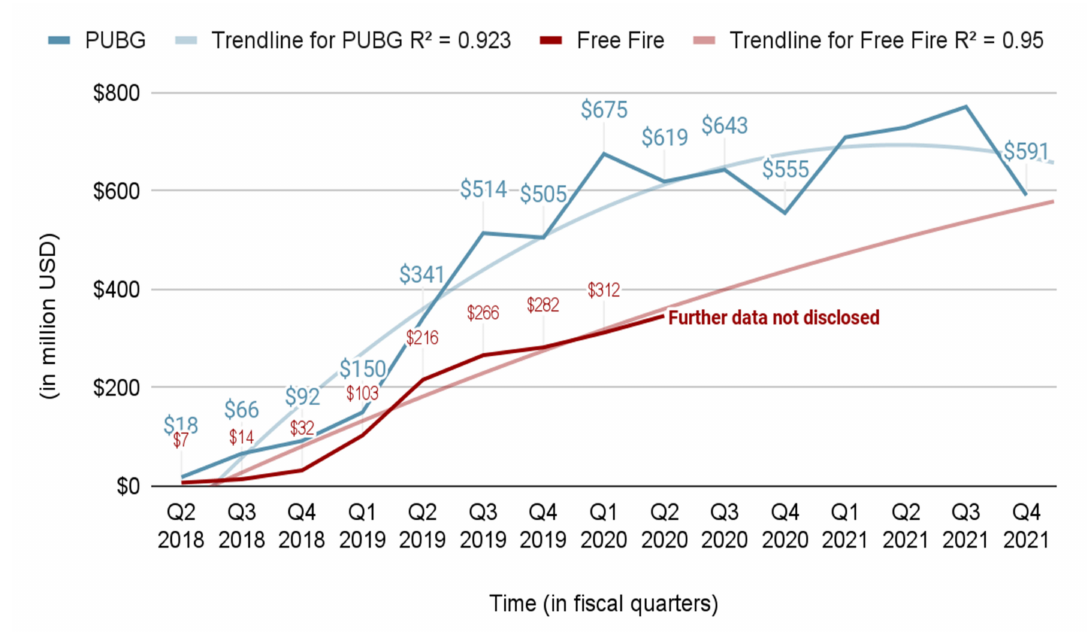
Figure 2. Growth in shooter games revenue (in USD million) [9,10].